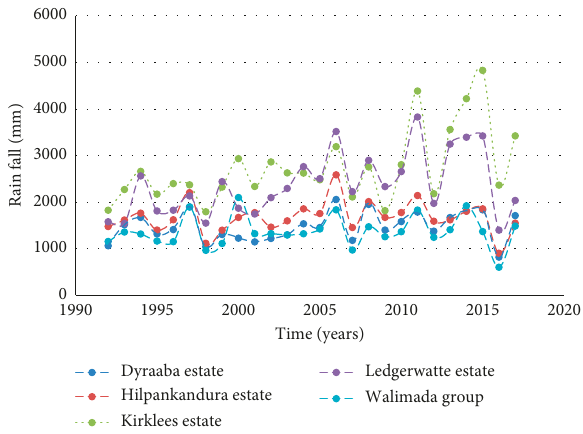
Figure 2: Annual rainfall